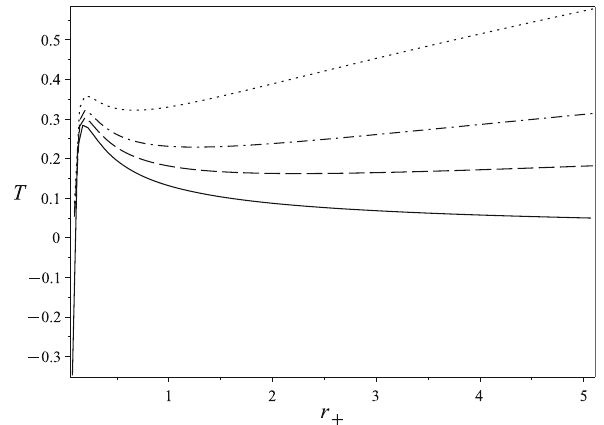
Fig. 3 Temperature as a function of horizon radius r + for several dif- ferent values of the cosmological constant (cid:2) . The solid, dashed, dash- dotted and dotted curves correspond to the cases (cid:2) = 0, (cid:2) = − 1, (cid:2) = − 2 and (cid:2) = − 4, respectively. The other parameters are held fixed, namely n = 3, α = 0 . 5, b = 1 and q = 0 .